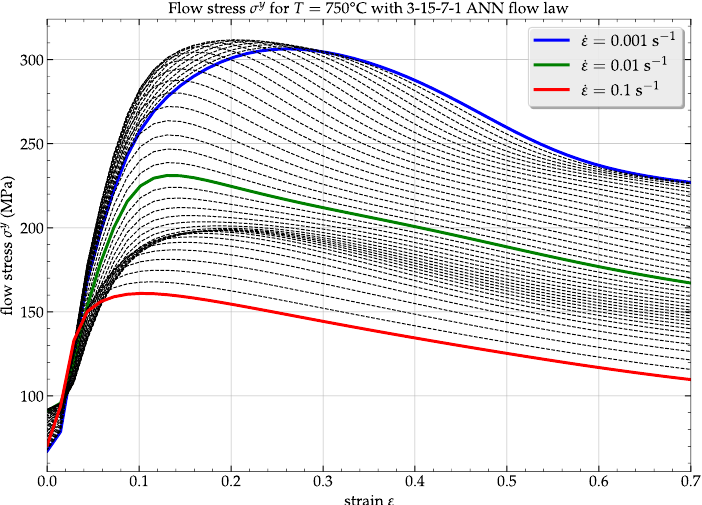
. ε ) for a fixed temperature T = 750 ◦ C using